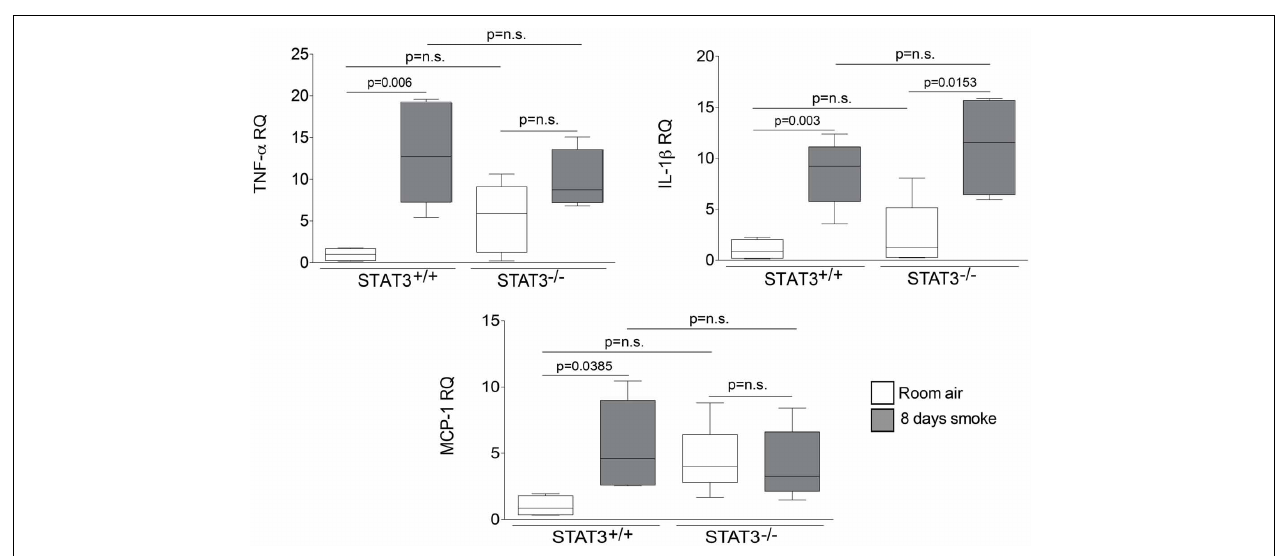
FIGURE 6 | STAT3 does not alter lung expression of TNF- α , IL-1 β or MCP-1. Quantitative PCR for mouse TNF- α , IL-1 β or MCP-1 was conducted on mRNA isolated from the lung tissue of room air and 8-day smoke exposed STAT3 + / + and STAT3 − / − mice using specific Taqman probes. Data are